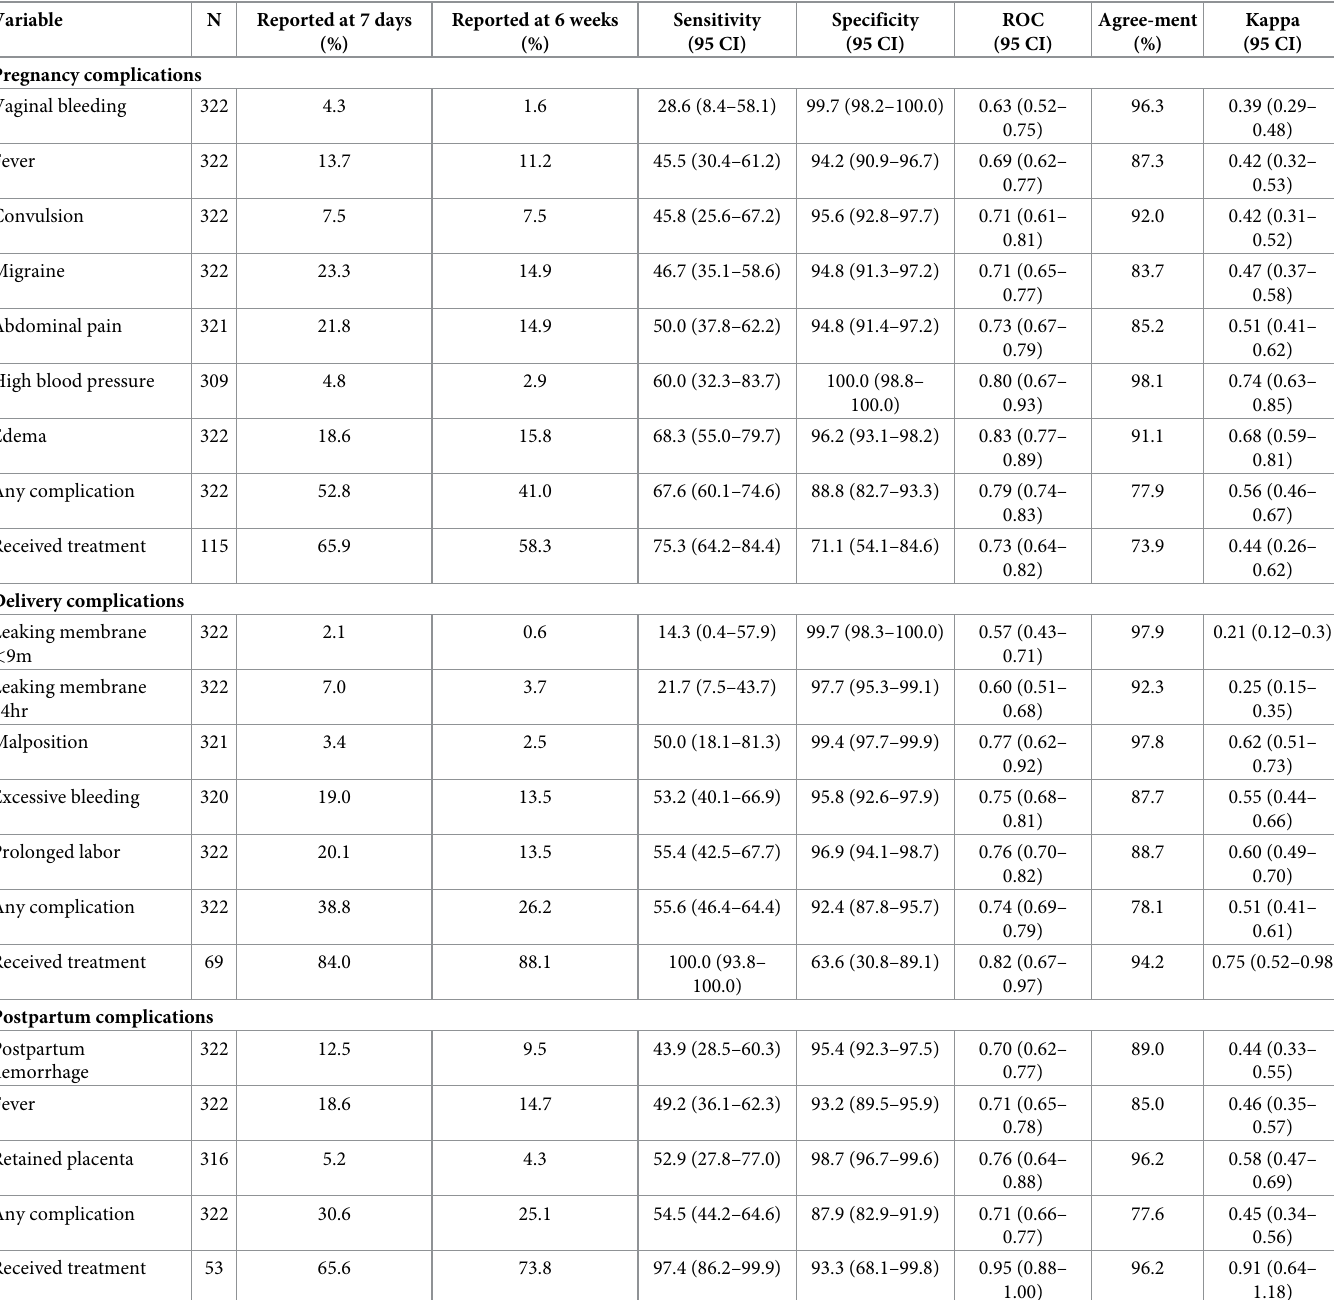
Table 4. Agreement diagnostics for select maternal pregnancy, delivery, and post-partum complications reported at 7-day and 6-week follow-up visits. Variable